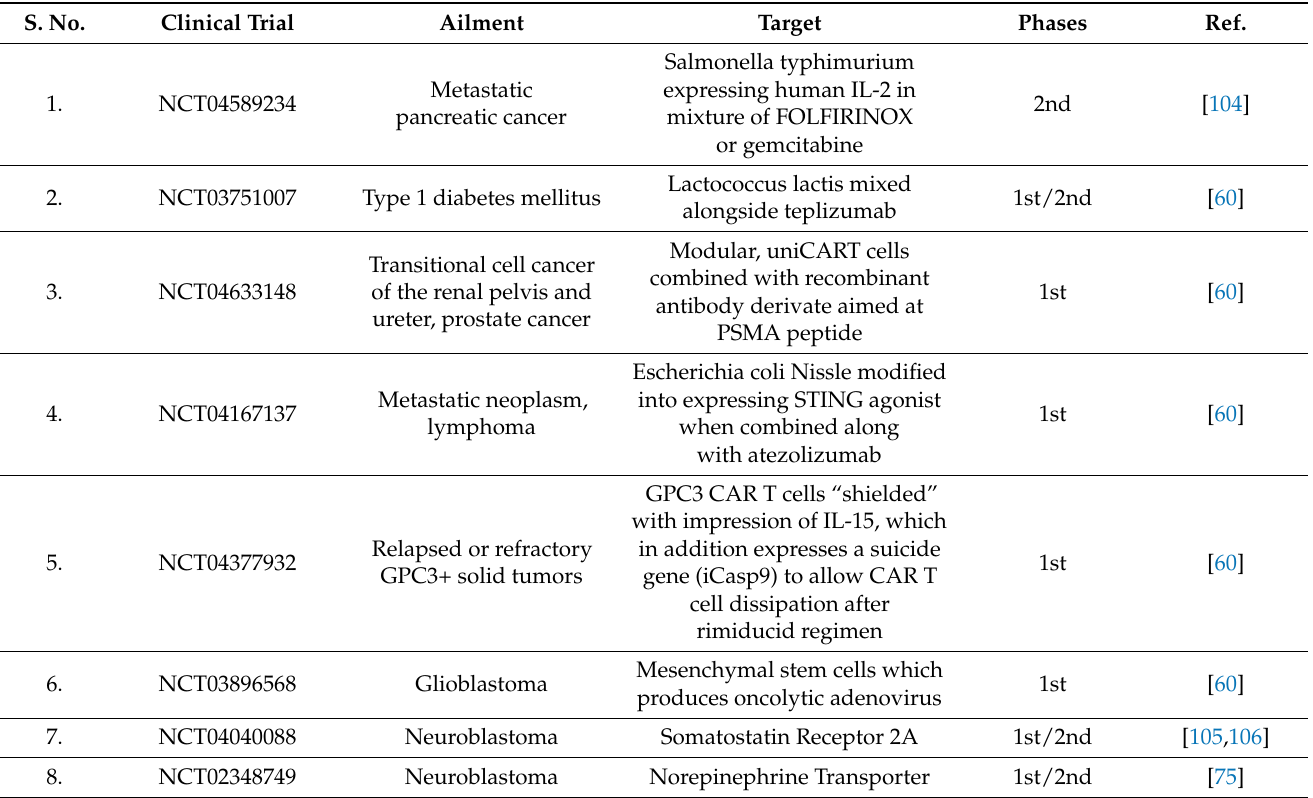
Table 3. Nanotheranostics targeting inflammation along with their stages of